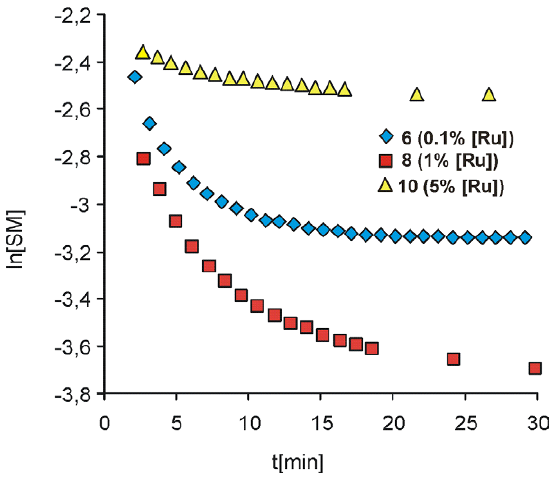
Figure 3. Log plots for 3 in the RCM of 6 (0.1% catalyst loading), 8 (1% catalyst loading) and 10 (5% catalyst